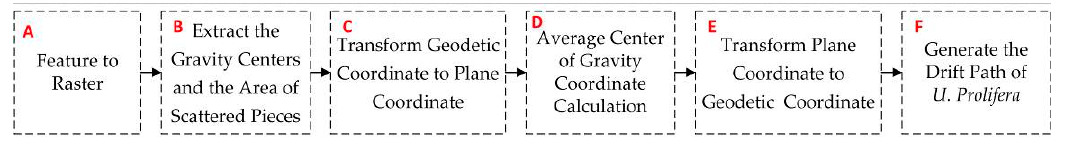
Figure 3. Data processing steps.